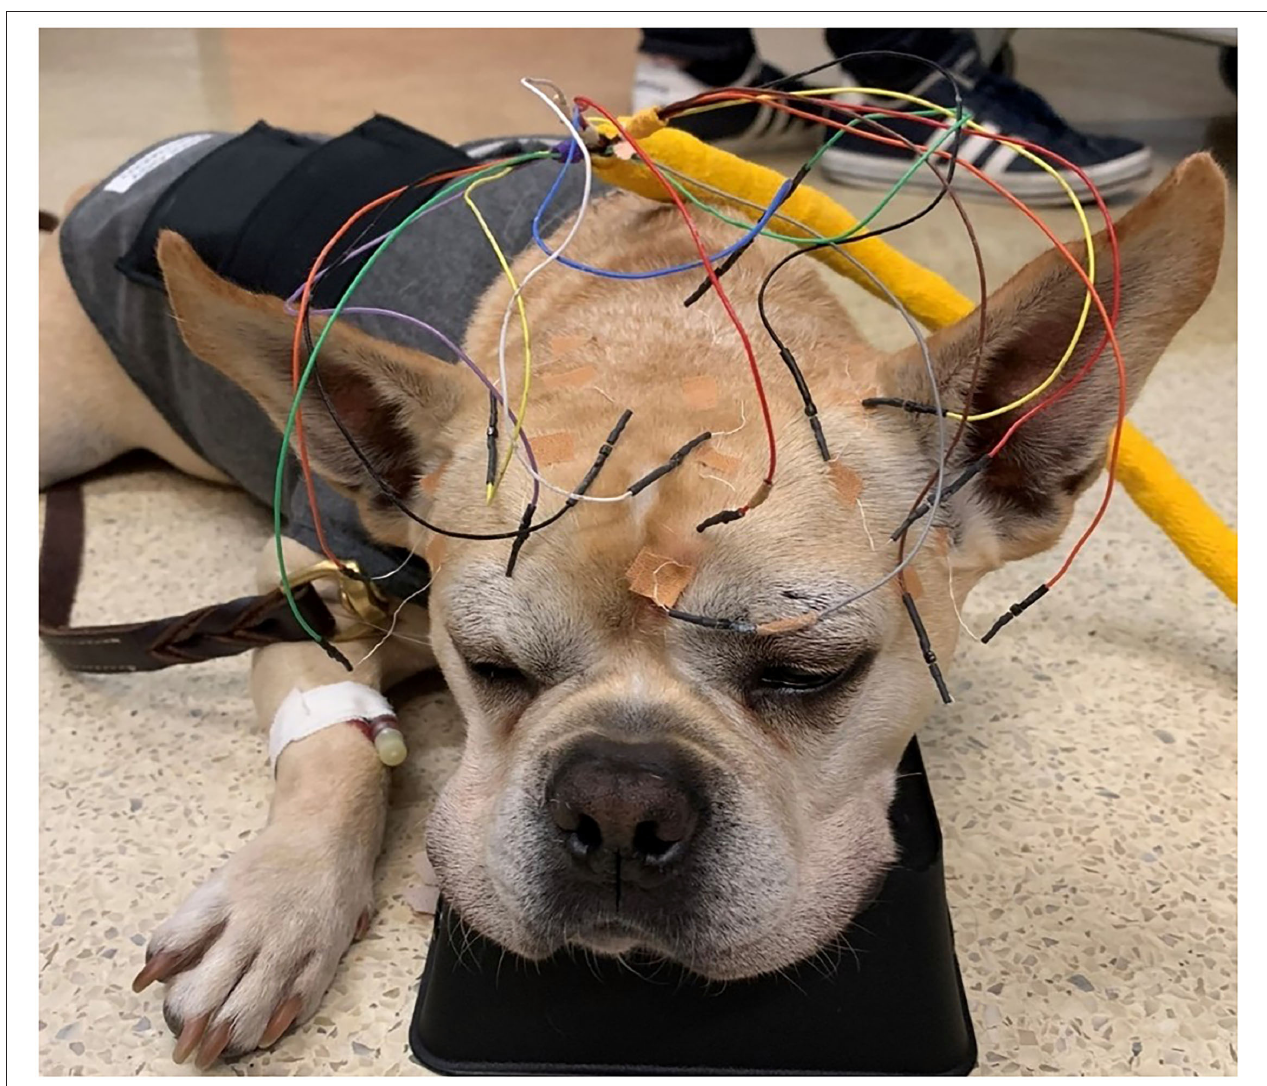
FIGURE 2 | Leads attached to the electrodes prior to the placement of the head bandage.